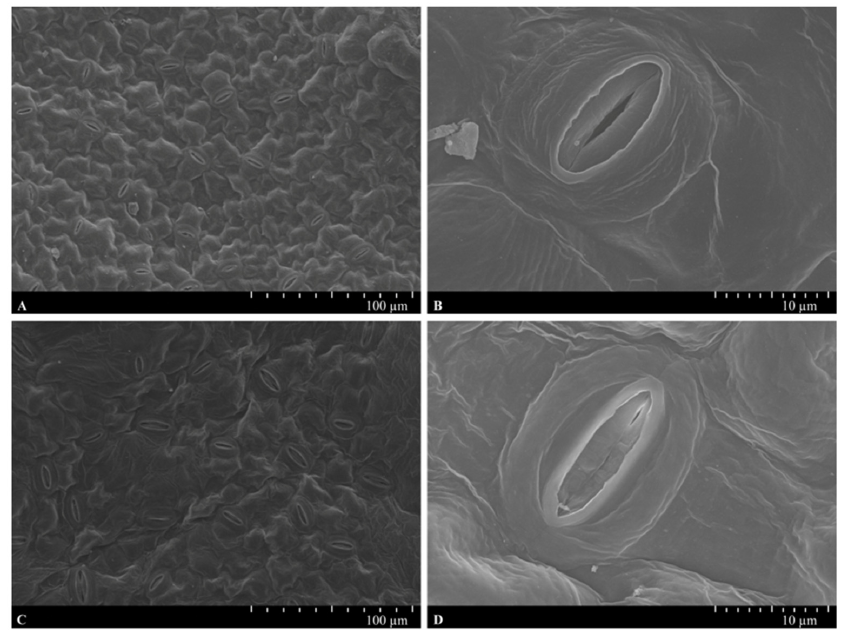
Figure 3. Scanning electron microscopy observation of ‘L45’ ( A , B ) and ‘L39’ ( C , D ) leaves under waterlogging stress for four days.